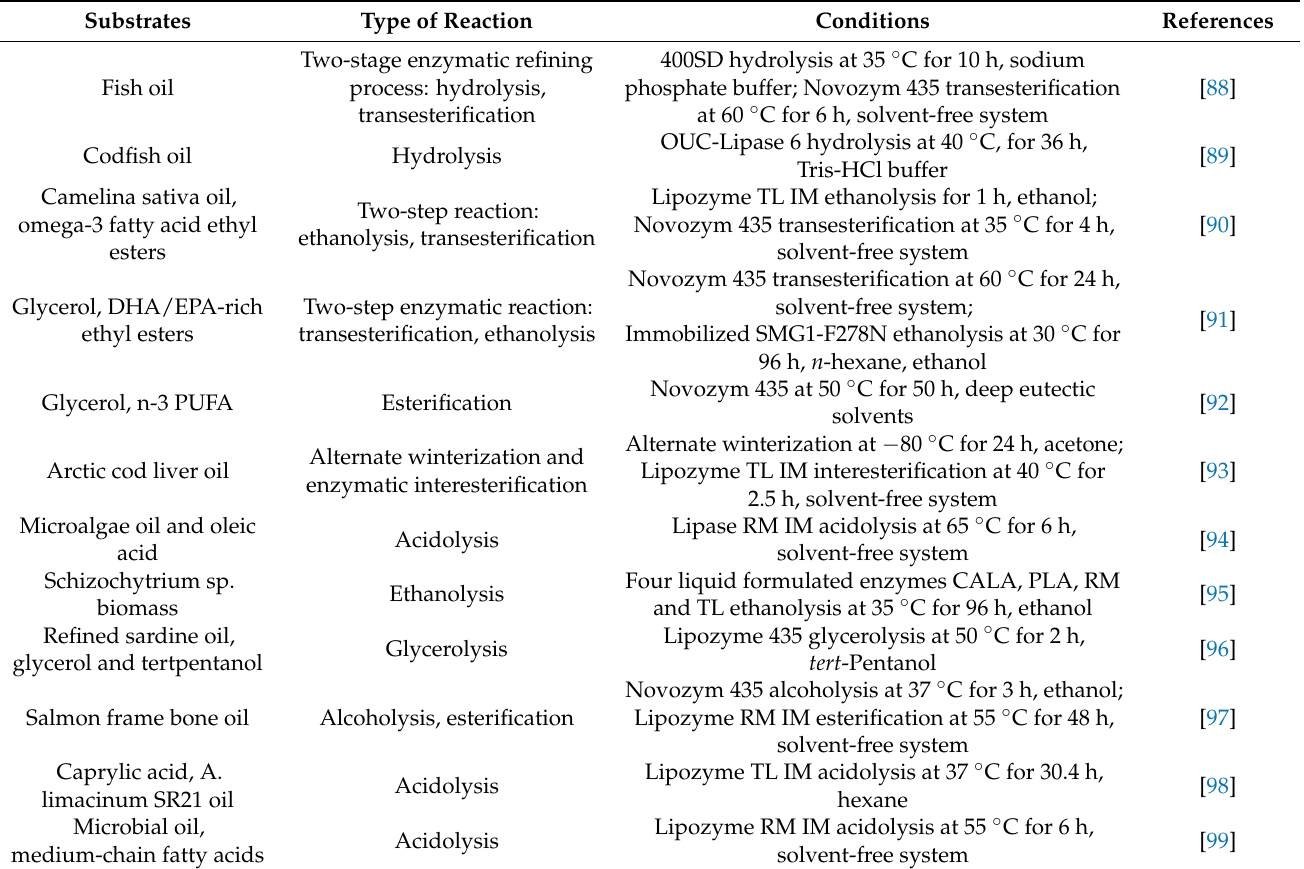
Table 5. Current enzymatic synthesis methods to produce EPA- and DHA-enriched